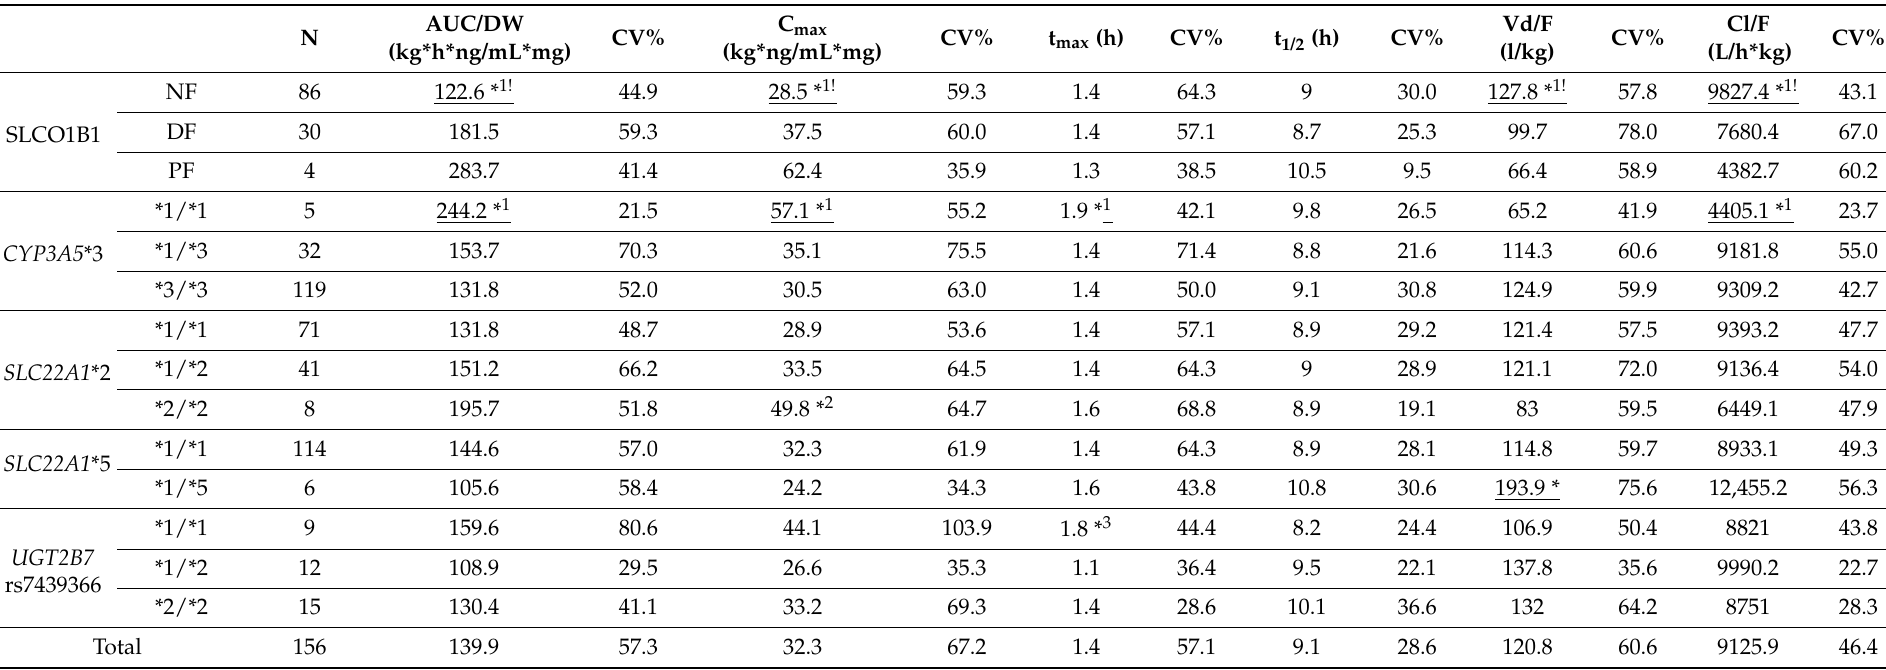
Table 4. Atorvastatin pharmacokinetic parameters based on genotypes or phenotypes with significant